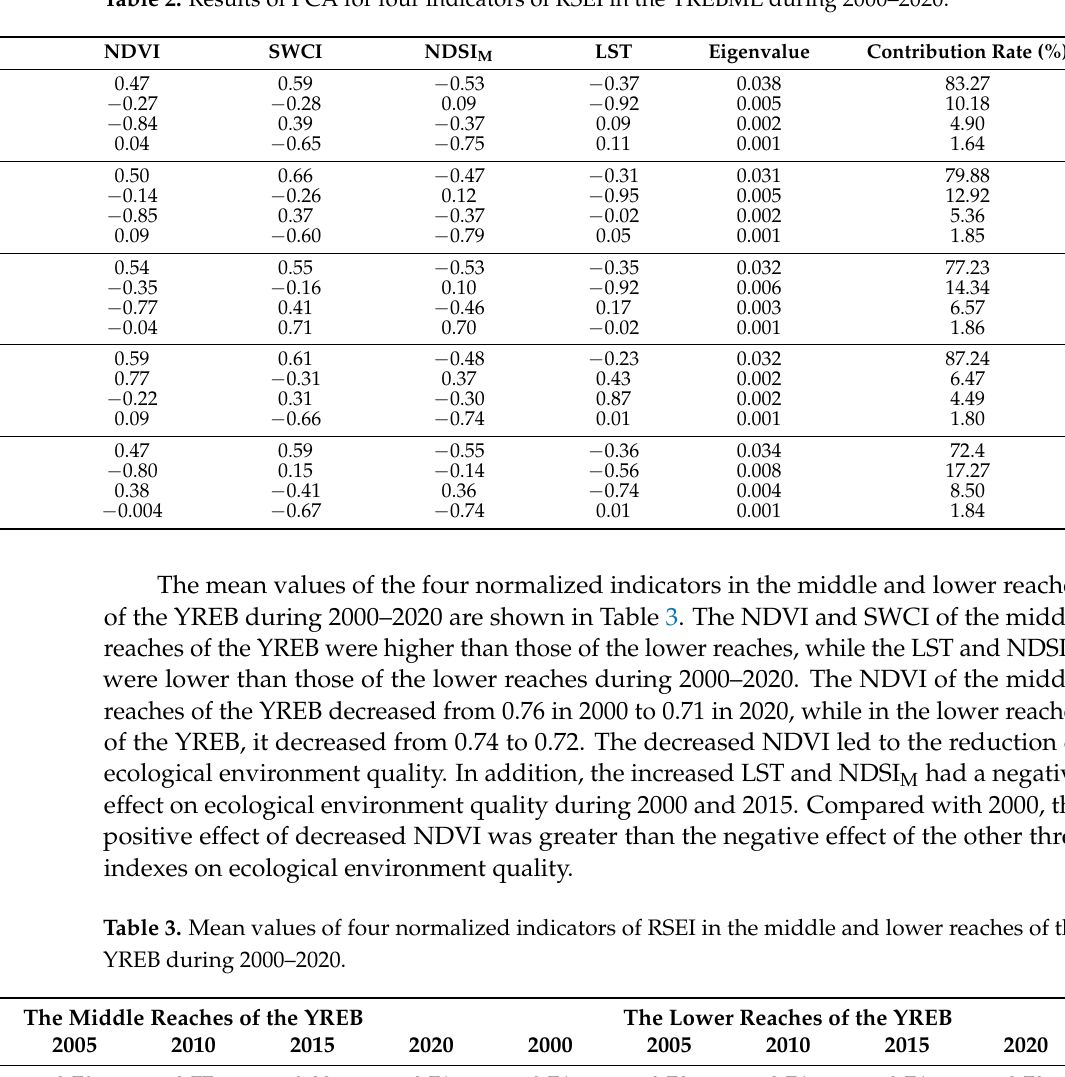
The Middle Reaches of the YREB The Lower Reaches of the